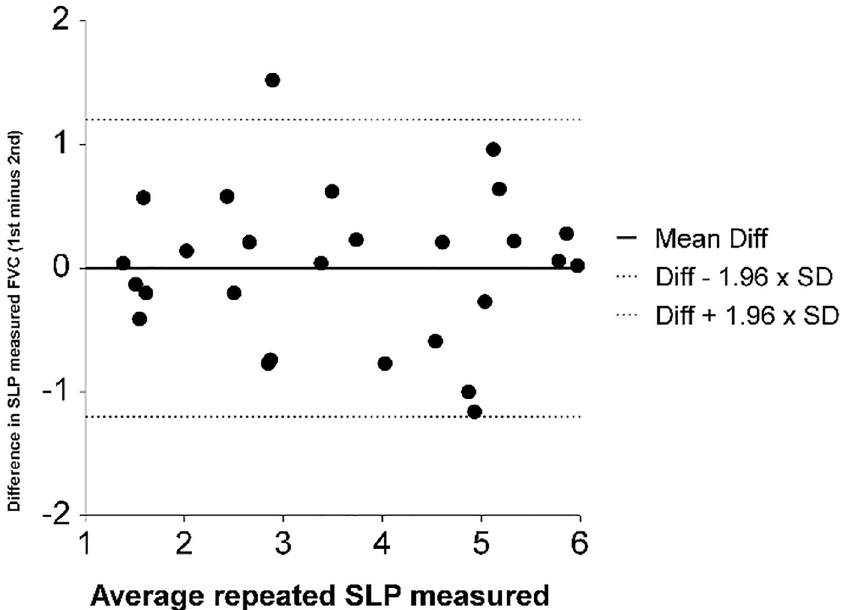
Fig 3. Bland & Altman plot of the difference between the two repeated SLP measurements of FVC (SLP estimated Litres) on the y-axis and the average of the two measures on the x-axis. The mean difference between paired measurements was 0.004 and the 95% Limits of agreement were -1.2 to 1.2 L.